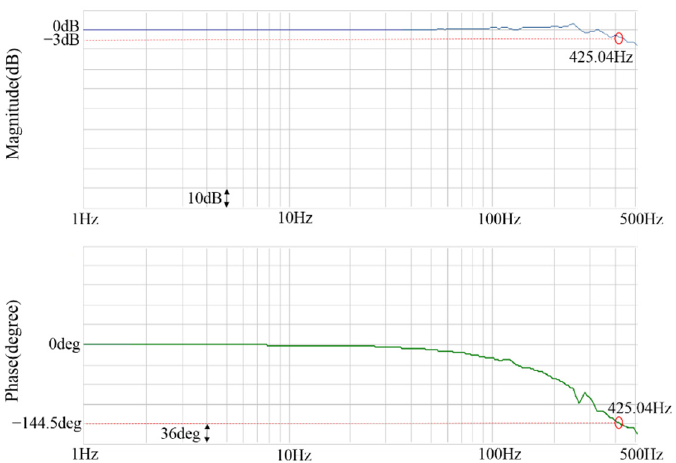
Figure 18. Bode plots of q -axis current control loop using PI-type SMC at 2000 rpm with 4.75 Nm.